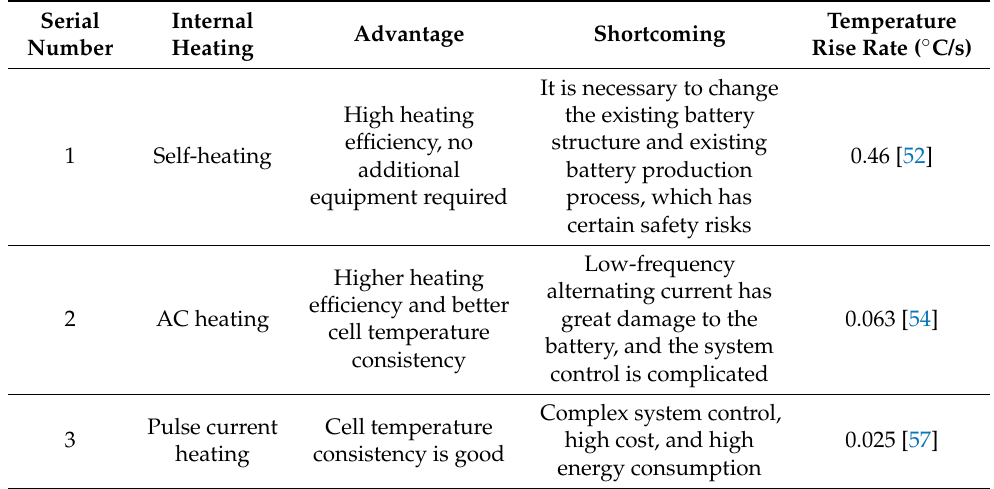
Table 2. A simple comparison of the characteristics and rates of three internal heating